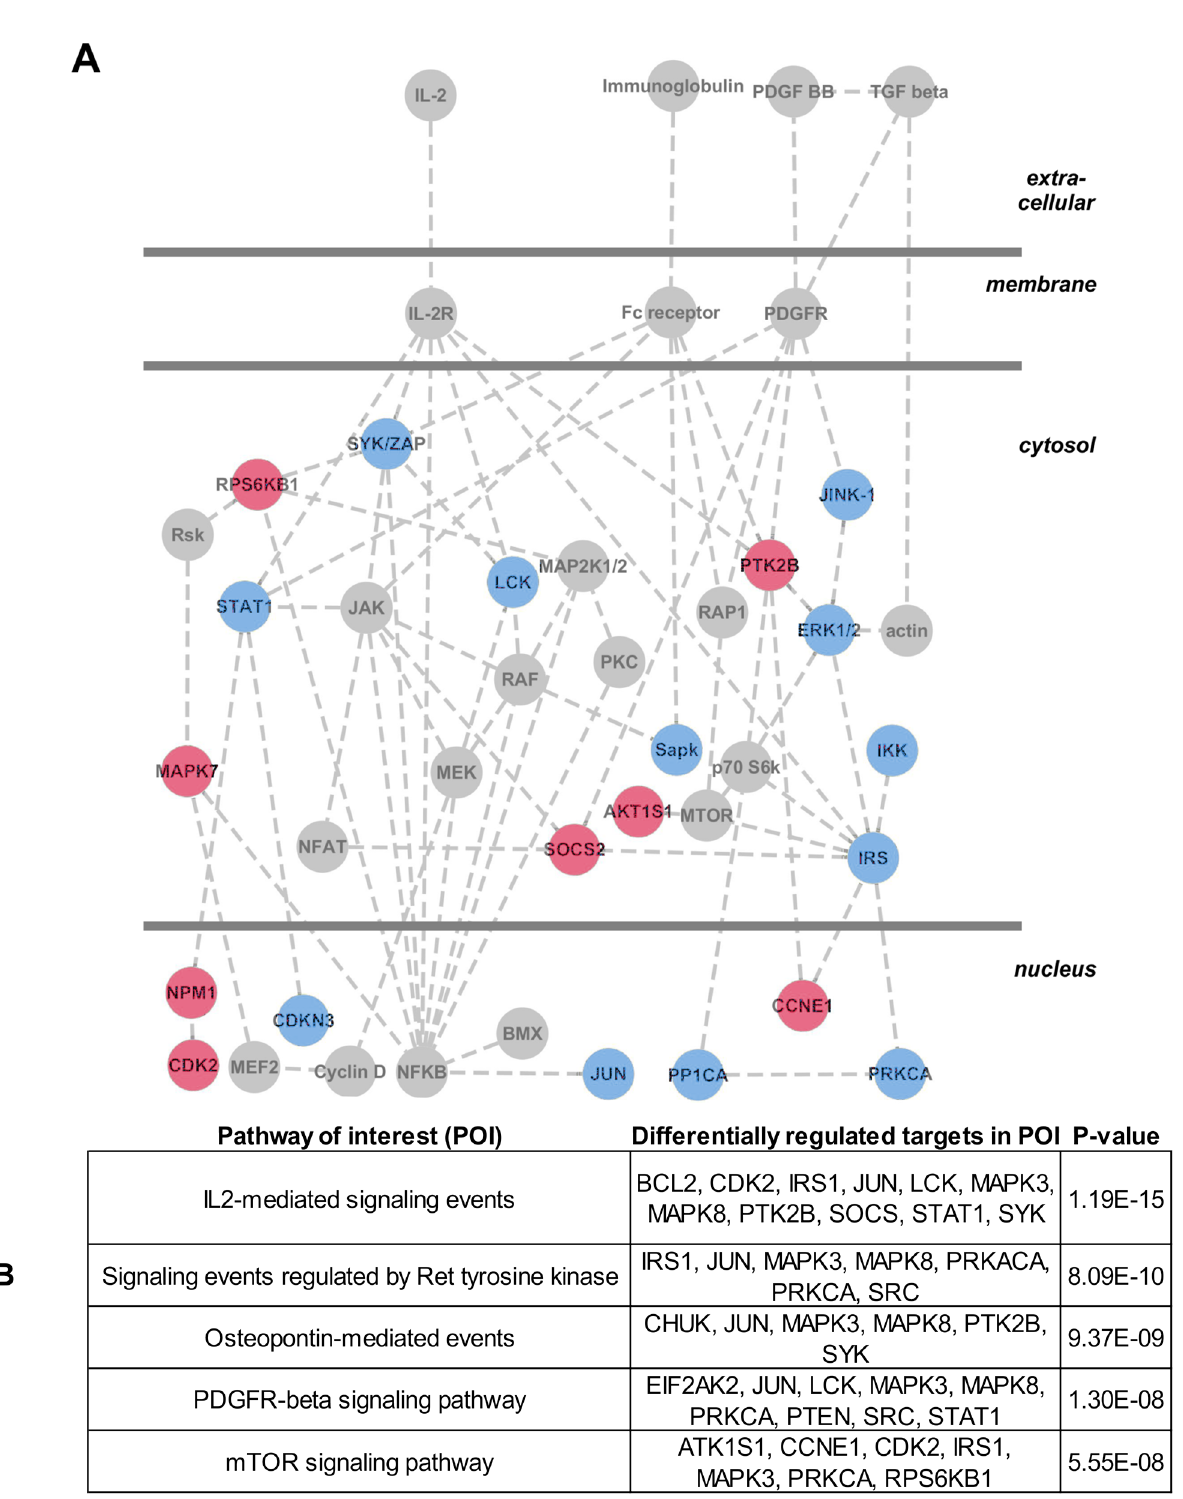
PLOS ONE | DOI:10.1371/journal.pone.0131216 July 1,